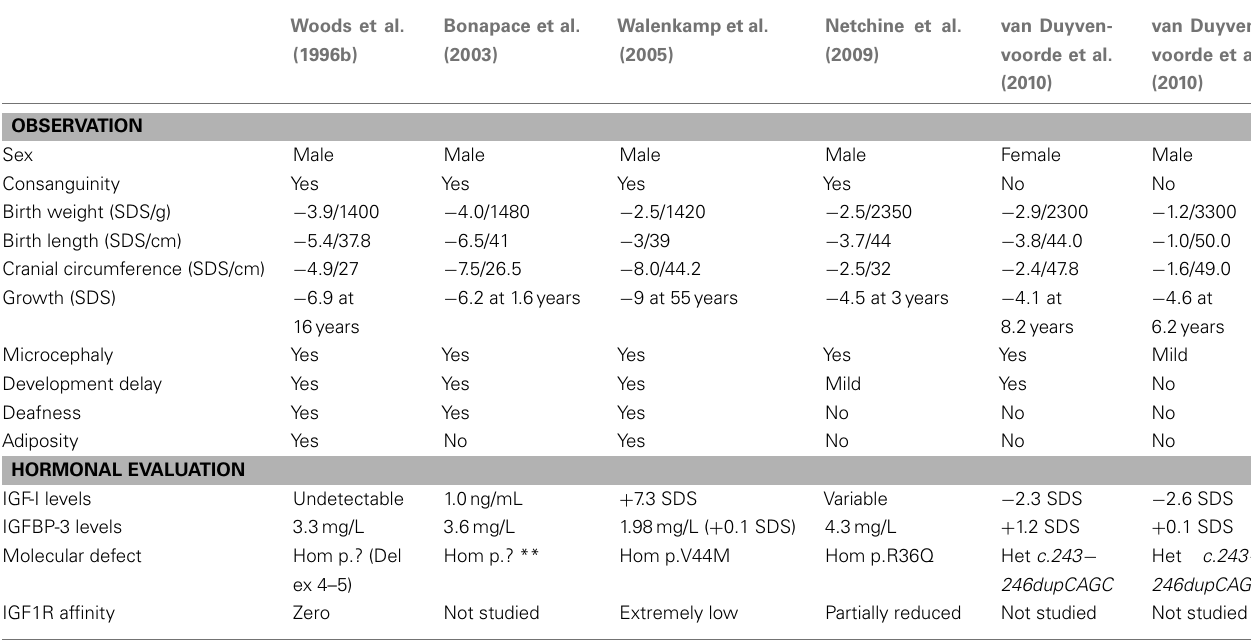
Table 3 | Characteristics of six cases with IGF1 defects.